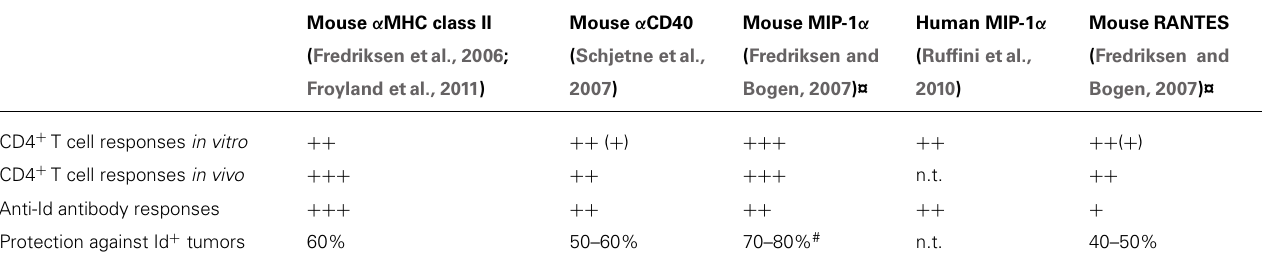
Table 1 | Efficiency of various targeting units inAPC-targeted